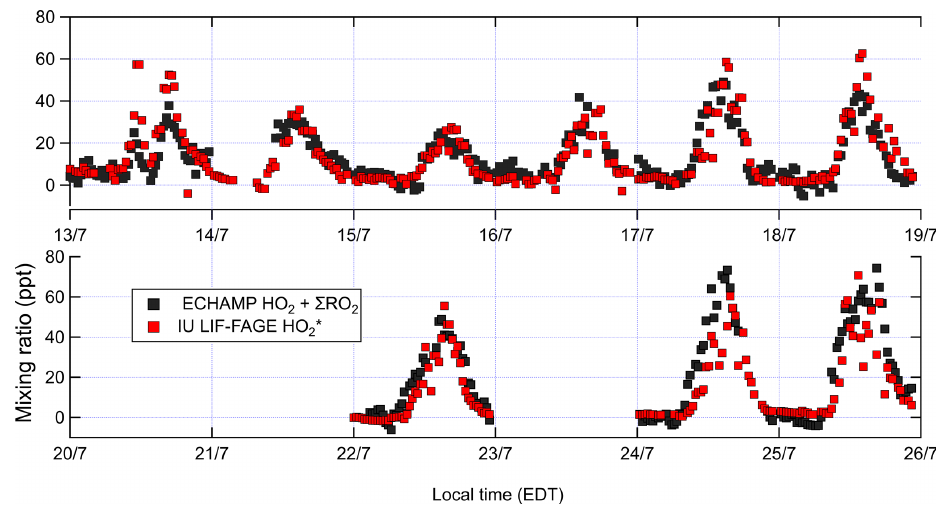
Figure 4. Concentrations of ambient total peroxy radicals (XO 2 ) by ECHAMP and HO ∗ by IU LIF-FAGE; 30min averaged measurements 2 , measurements are 1min averages every 30min. The vertical grid lines indicate midnight for are shown for ECHAMP XO 2 . For HO ∗ 2 odd-numbered days, in local time (EDT – eastern daylight